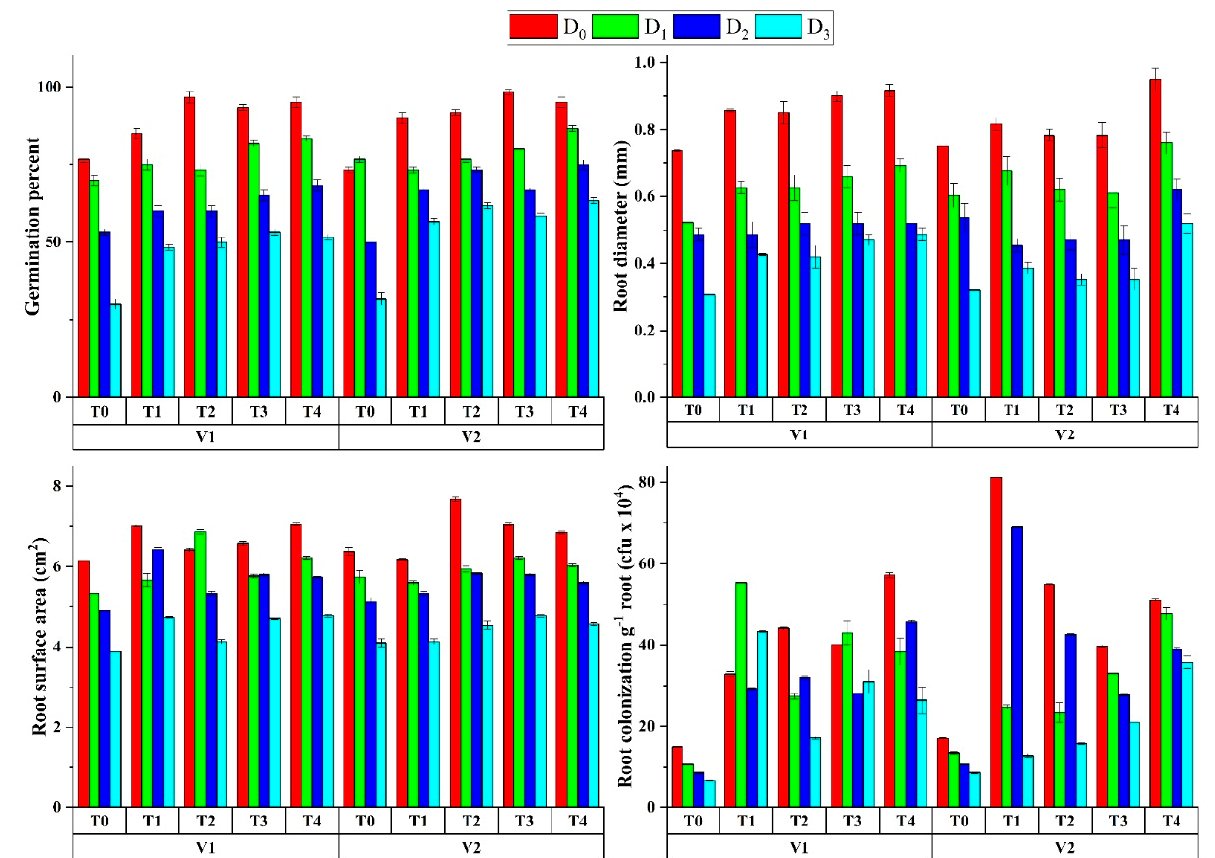
Figure 3. Efficiency of exopolysaccharide-producing, drought-tolerant rhizobacterial strains to improve seed germination, root development, root diameter; root surface area and root colonization; V1: Johar-16; V2: Gold-16.